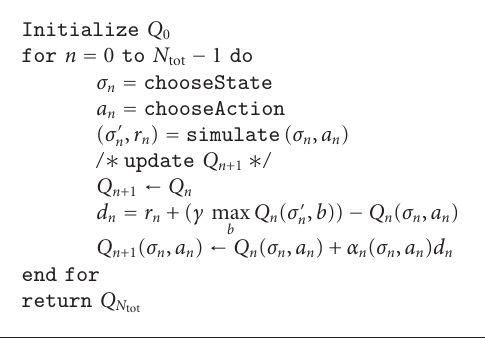
Algorithm 1: The Q-learning